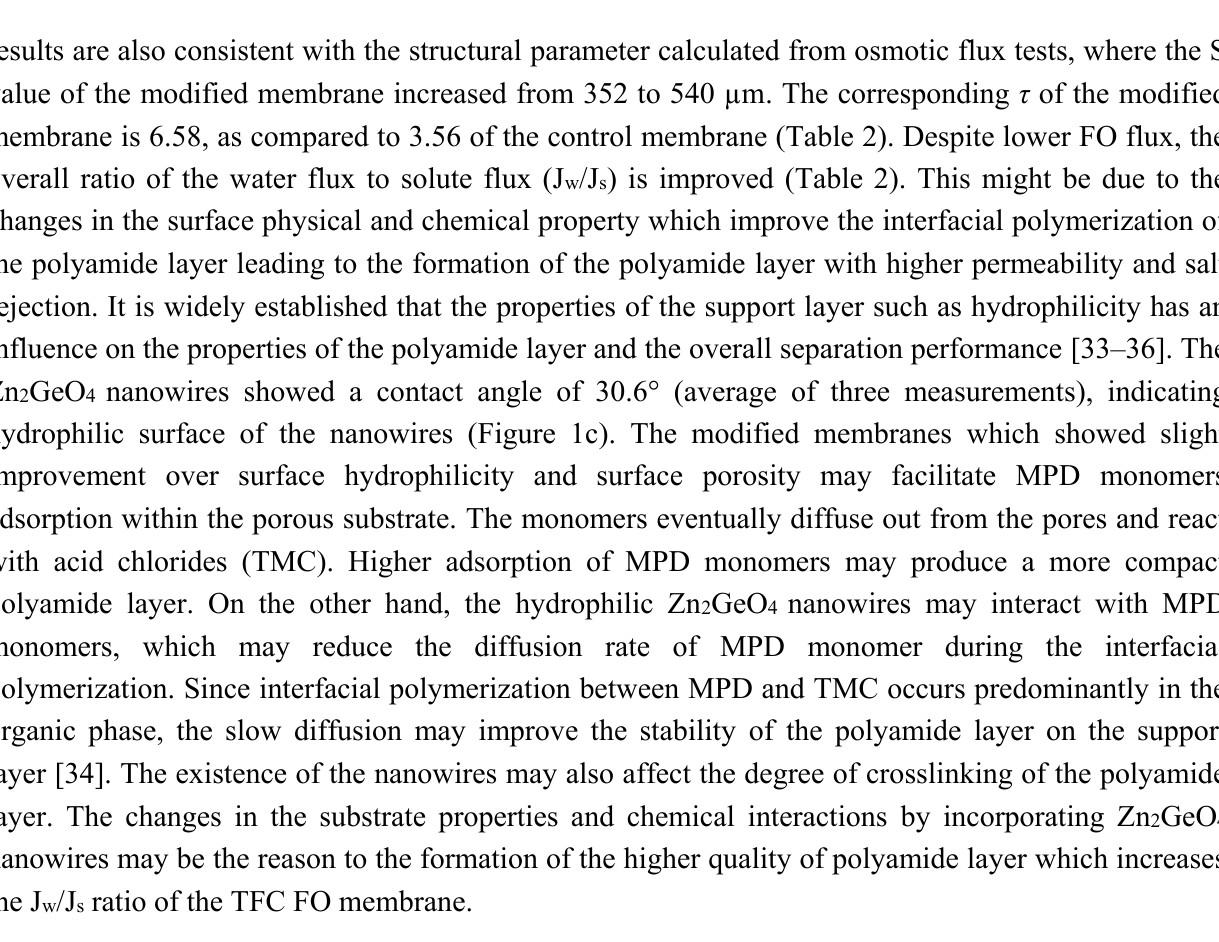
Table 1. Properties of control, modified and commercial